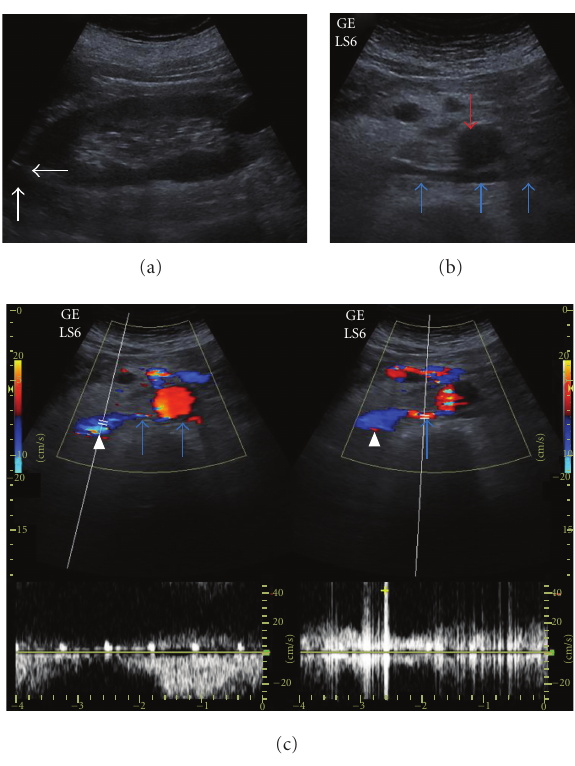
Figure 1: Ultrasonography (US) shows a hypoechoic solid mass in left adrenal location in longitudinal view (white arrows) (a). In transverse images, US demonstrates retroaortic left renal vein (RLRV) (blue arrows), originating from left renal hilus, passing posteriorly to the abdominal aorta (red arrow) and anteriorly to the vertebral corpus, and joining inferior vena cava (white arrowhead) (b). Color Doppler demonstrates RLRV (blue arrows) (c).